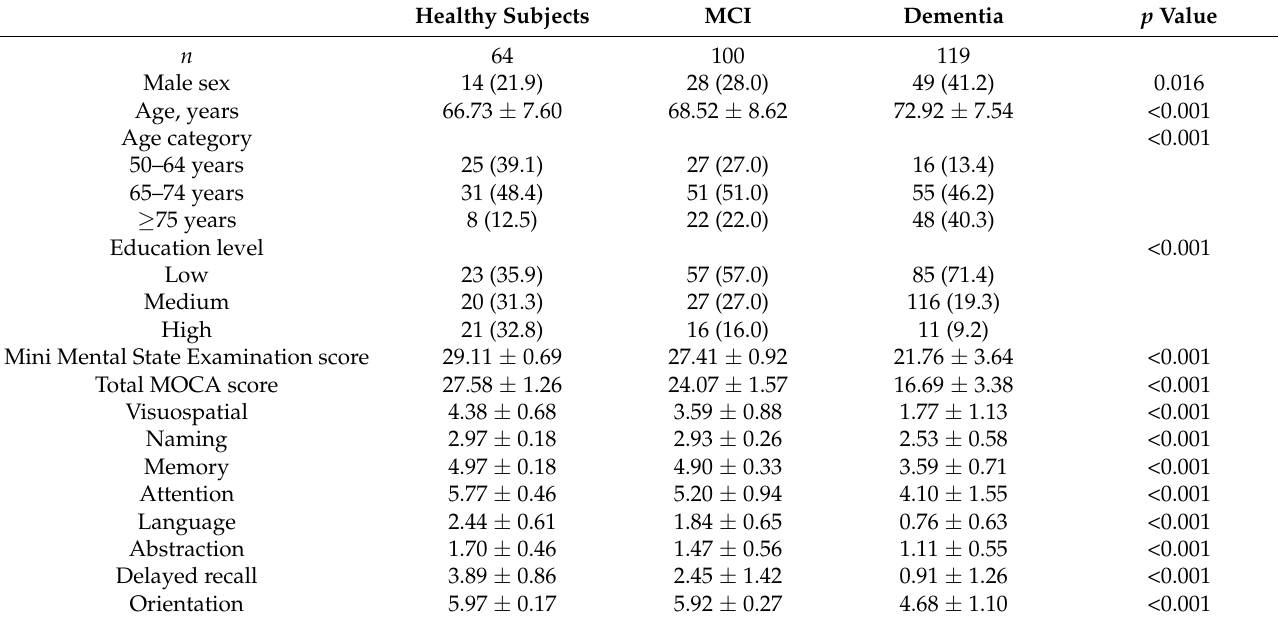
Table 2. Comparison of demographic and clinical characteristics between the three